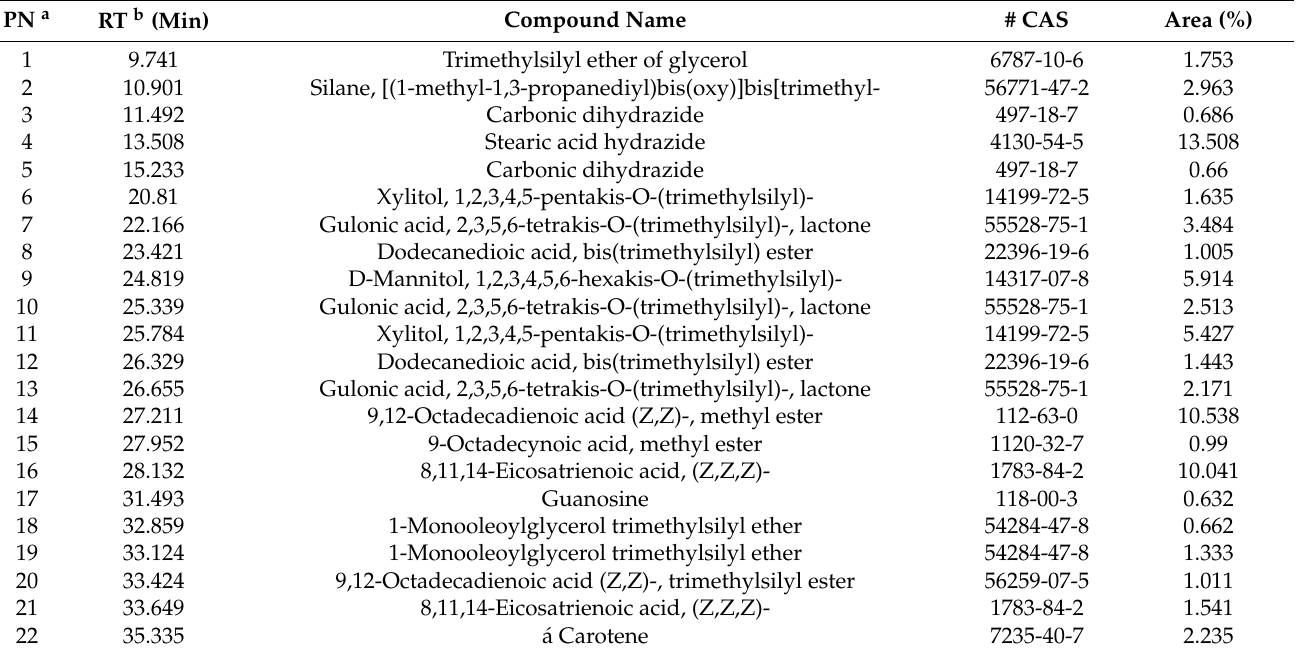
Table 5. Identification of organic compounds from post-fermented wheat bran by